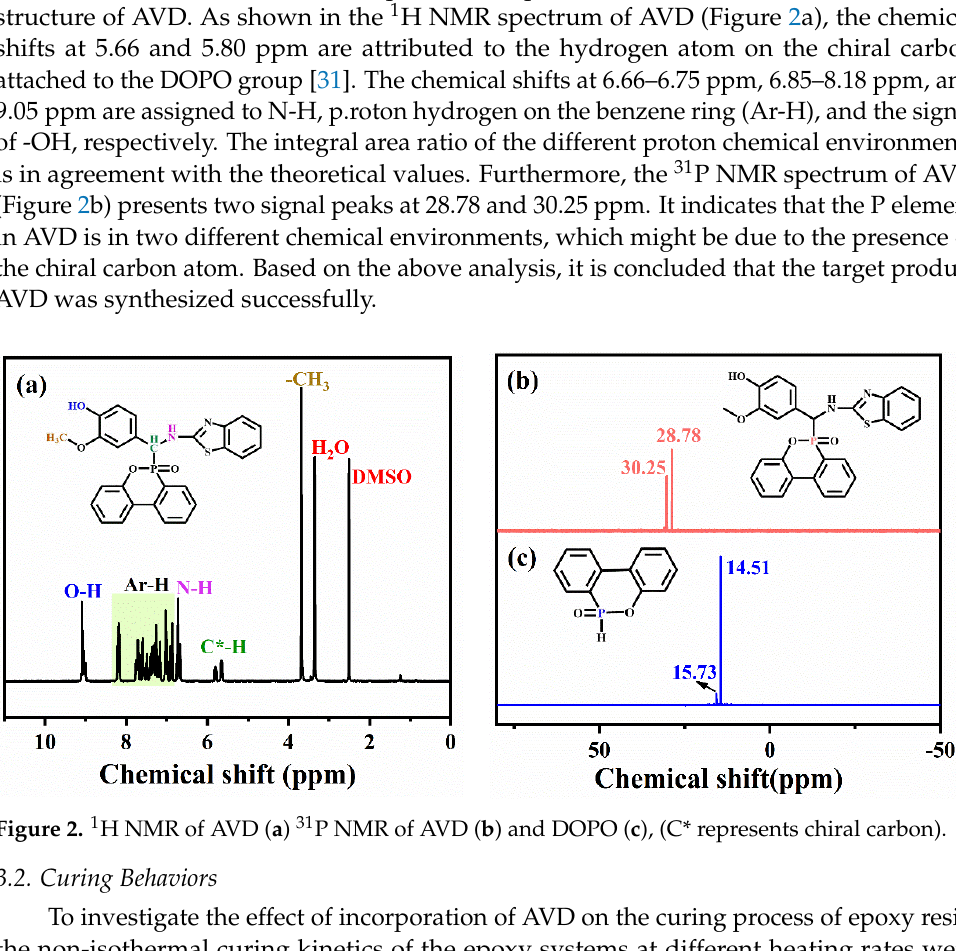
Figure 1. FTIR spectra of DOPO, VN, ABT and AVD.